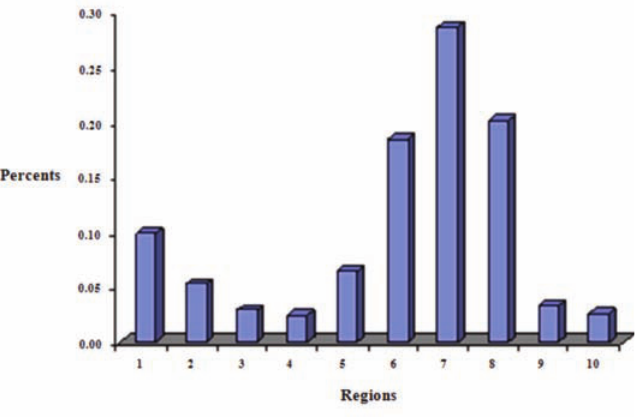
Figure 6. The percentage of occurrences in each region, with the zoning by Sadeghian (present study).